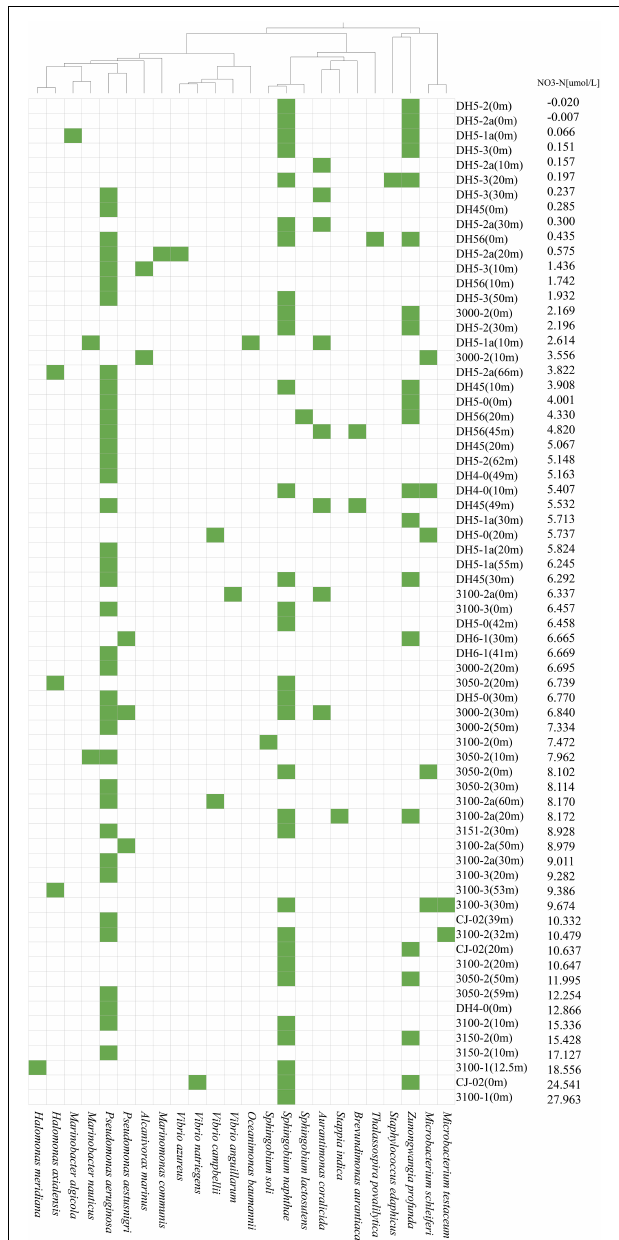
FIGURE 3 | Distribution of isolates at different levels of DO, NO 2 − -N, NO 3 − -N at the 17 different sampling stations.